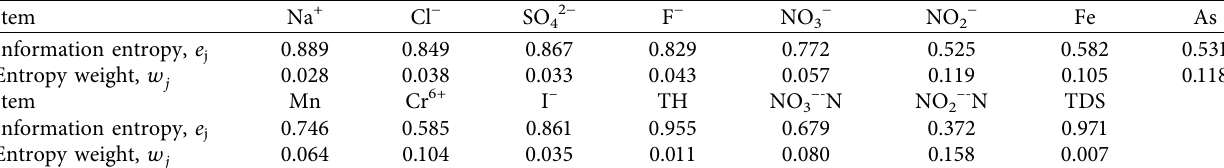
Table 3: Entropy weight of hydrochemical parameters.